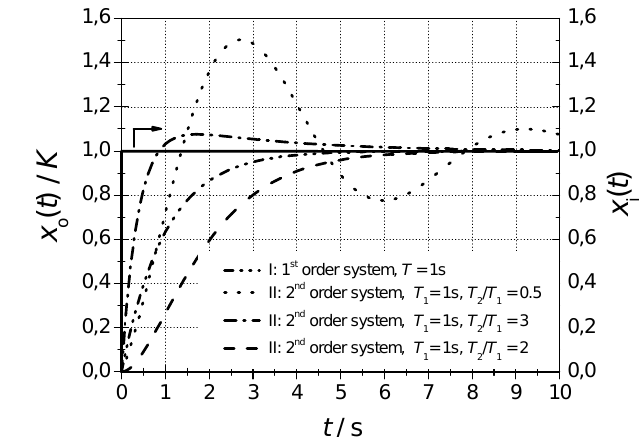
Figure 10. Normalized sensor output signals x o / K for the di ff erent sensor types and di ff erent sensor parameters (interrupted lines) for a unit step input (solid line).